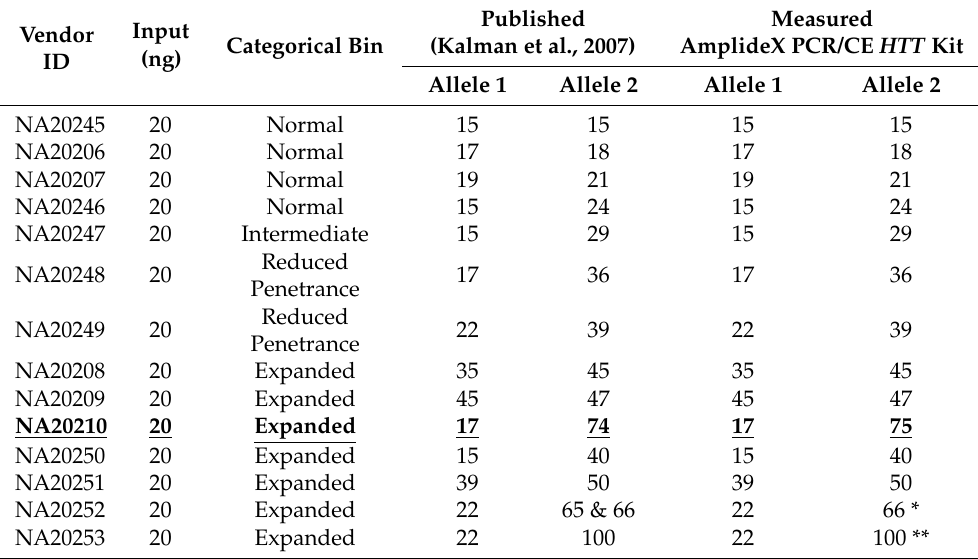
Allele genotypes for Coriell samples shown from Kalman et al. [30] are the mode; error limits were set at ± 1 for alleles ≤ 42 repeats and ± 3 repeats for alleles >42 CAG repeats, according to the European Molecular Genetics Quality Network best practice guidelines for the molecular genetic testing of Huntington disease [31]. * A 63 CAG mosaic allele was also detected. ** A 128 CAG mosaic allele was also detected. Underlined and in bold, the difference between the two